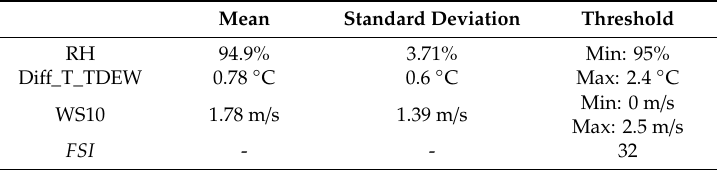
Table 12. Mean, standard deviation and thresholds selected for relative humidity, surface temperature / dew point depression and wind speed measured in fog condition and FSI threshold calculated using Youden’s index for